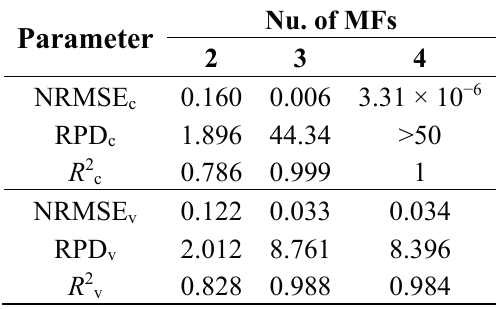
Table 9. Validation criteria for different fuzzy neural networks.